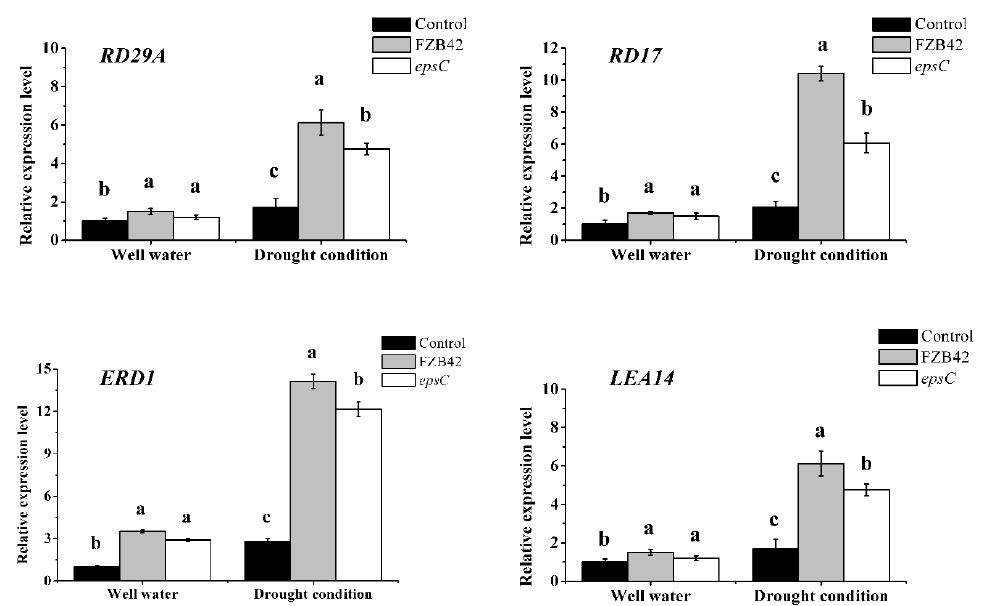
Figure 4. The relative expression levels of drought-responsive marker genes in the leaves of A. thaliana . A qRT-PCR assay was used to estimate the expression levels of the stress response-associated marker genes, RD29A , RD17 , ERD1 , and LEA14 , in drought plants inoculated with either wild type FZB42 or the epsC mutant. Values are shown as means, with the whiskers representing the standard error (SE, n = 18). Different letters above each column indicate statistically significant ( p < 0.05) differences in mean performance.